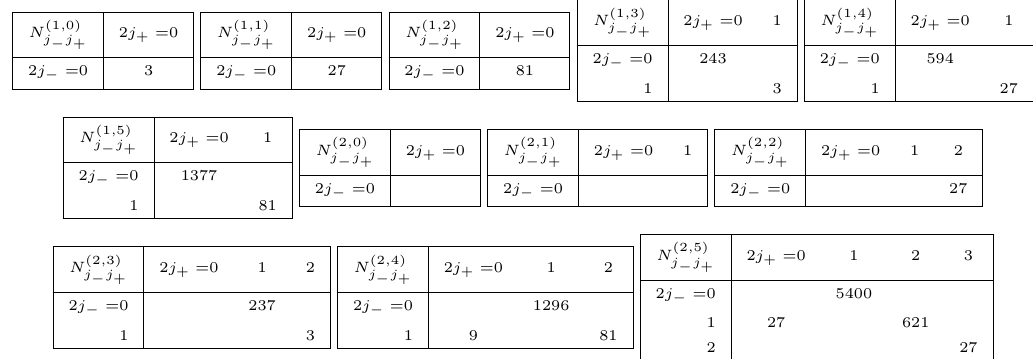
Table 13 . Re(cid:12)ned BPS invariants N ( b;d )